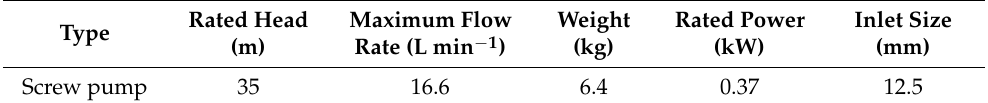
Table 1. Main pump parameters.